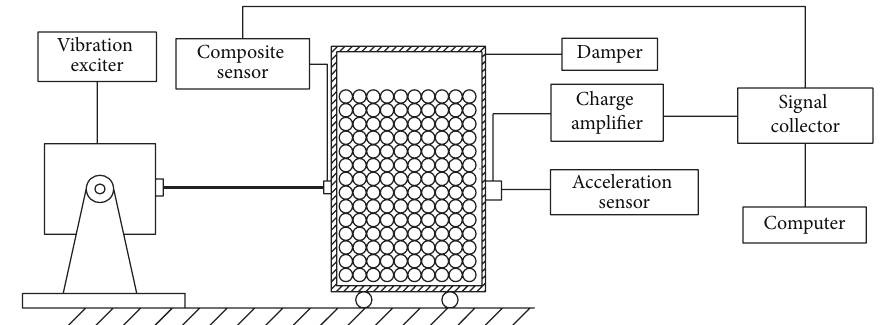
Figure 9: The schematic plot of experimental system.